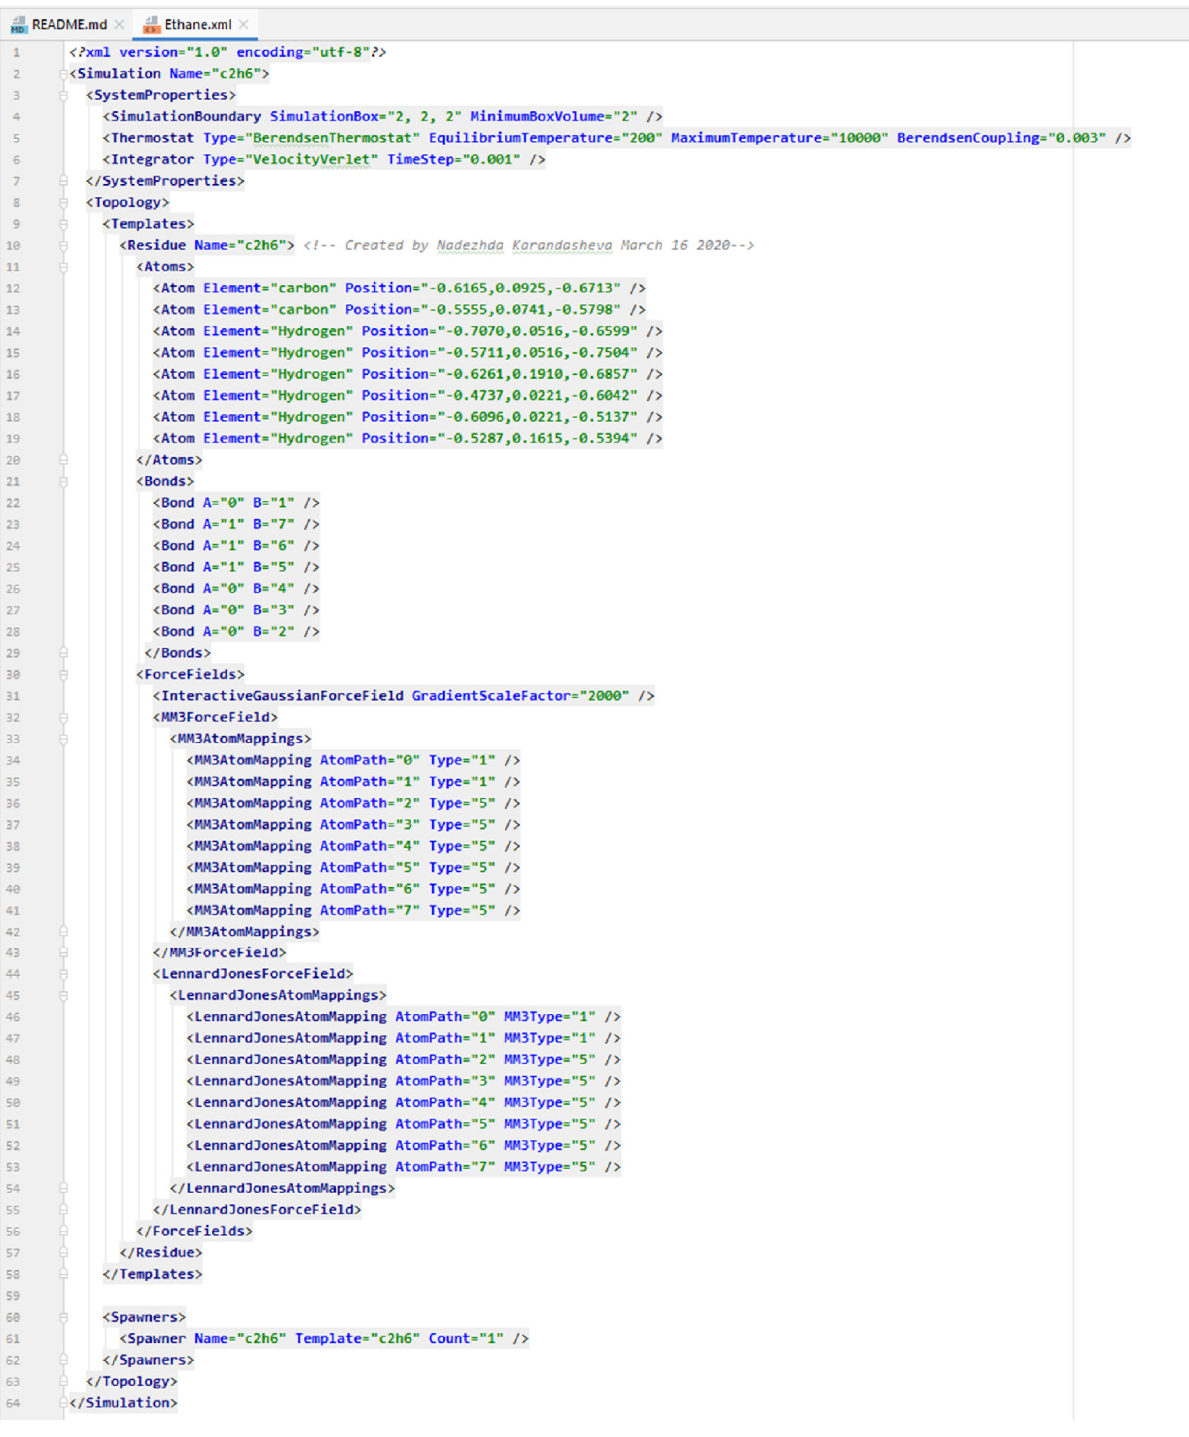
Figure 3. The example of the code converted into xml format.